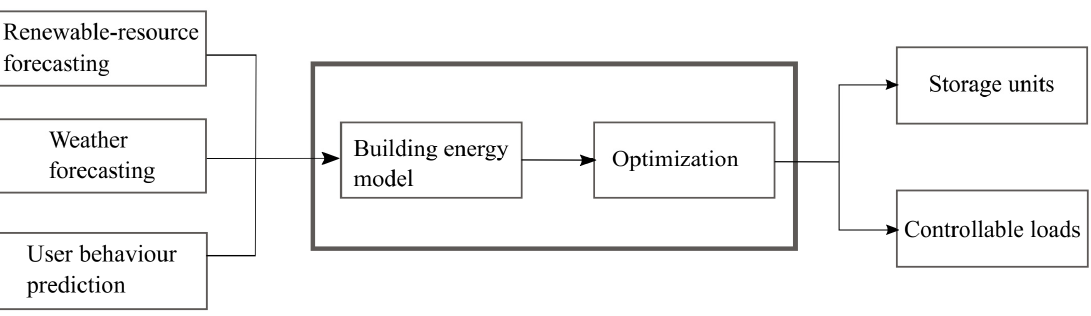
Figure 3. An example of a building control schematic.